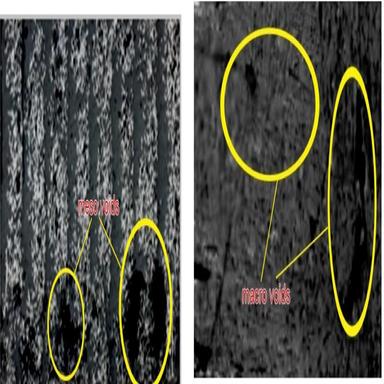
(a) Meso voids and (b) macro voids between fiber bundles after deposited inside a layer.